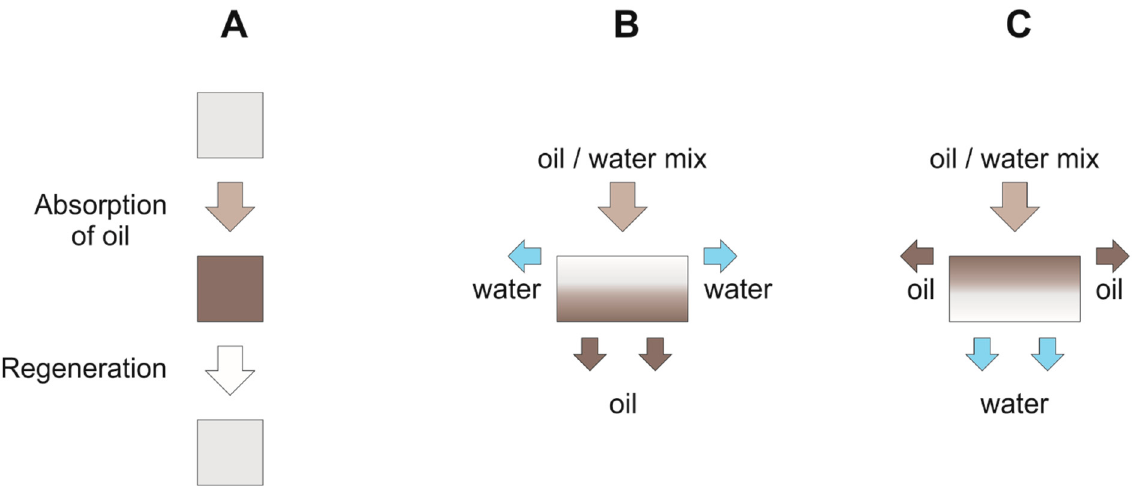
Figure 4. Separation mechanism of 3D materials: ( A ) absorber type; ( B ) hydrophobic filters; ( C ) hydrophilic filters.